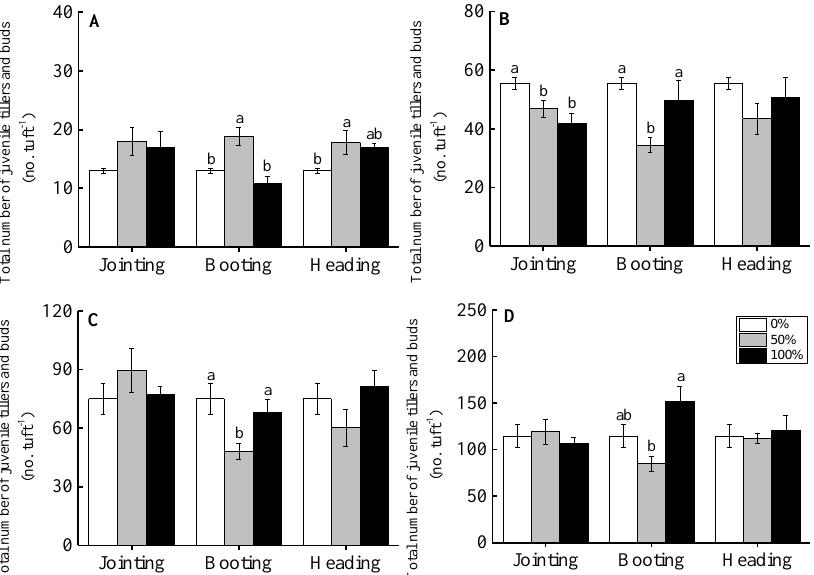
Figure 4. The effects of clipping intensity on total number of juvenile tillers and buds of H. brevisubulatum at different grades when clipped at the jointing, booting, and heading periods. A , B , C , and D represent the grades (1, 2, 3, and 4, respectively) of the tuft diameters of H. brevisubulatum . Di ff erent lowercase letters represent significant di ff erences among di ff erent clipping intensities ( p <